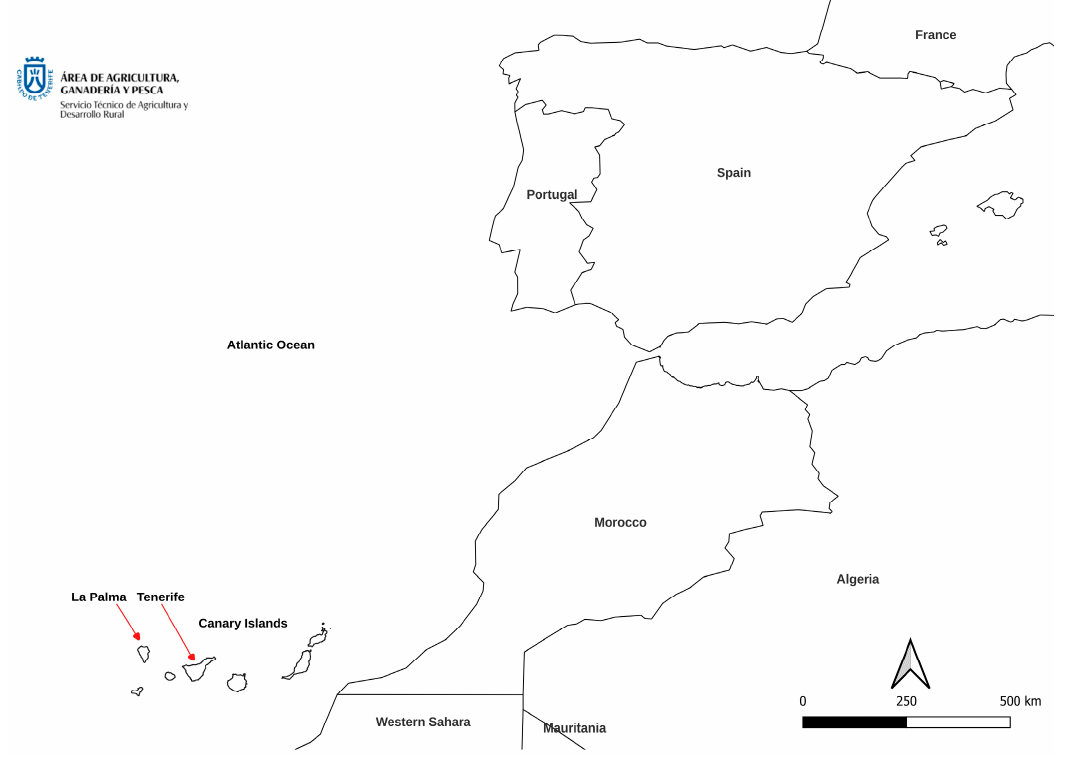
Figure 1. Localization of the Canary Islands.